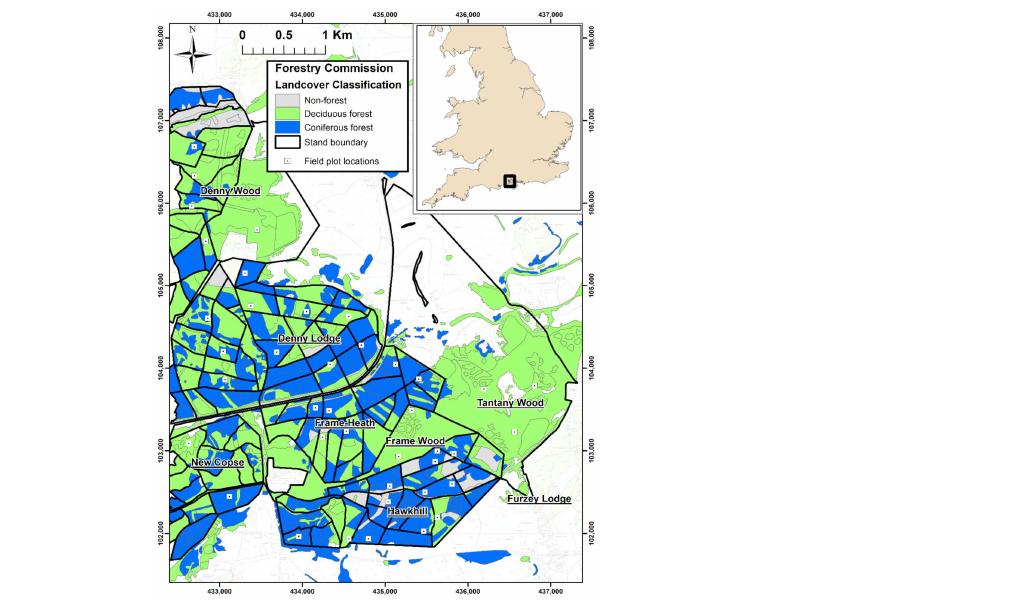
Figure 1. The complete study area extent in the New Forest, UK. Forestry Commission primary habitat codes are provided for reference illustrating the locations of coniferous and deciduous forest. Black lines represent stand boundaries and grey lines represent subcompartment boundaries. Field plot locations are also indicated. Table 1. List of key ecological factors recorded for each of the field plots installed within the New Forest field site. The acronym DBH stands for diameter at breast height. The indicators marked with an * were used as determinants of ‘favourable conservation status’ following from